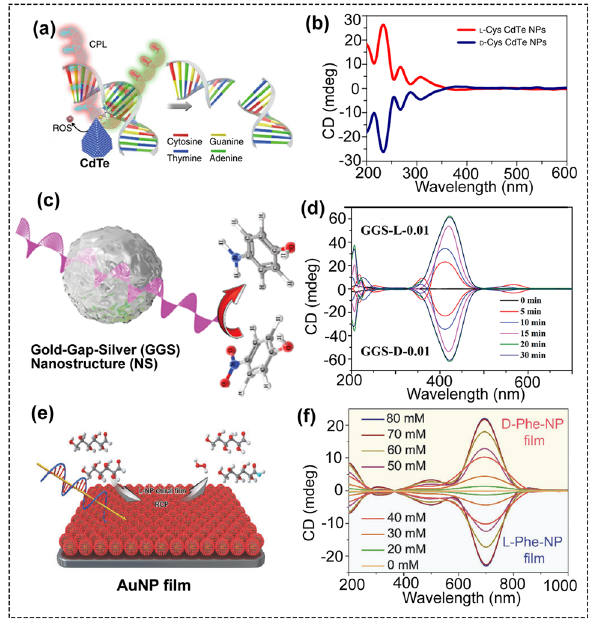
Fig. 7 a Schematic illustration of chiral CdTe-based specific DNA cleavage under CPL irradiation. b CD spectra of the chiral CdTe NPs (reproduced with permission from Ref. [88]. Copyright 2018 Nature publishing group). c Schematic illumination of the photocatalytic reduction of 4-nitrophenol by chiral Gold-Gap-Silver (GGS) nano- structures (NS). d CD spectra of GGS nanostructures prepared at different reaction times (reproduced with permission from Ref. [90]. Copyright 2015, WILEY–VCH GmbH). e Schematic illumination of photocatalytic oxidation of glucose enantiomers by chiral AuNP film. f CD spectra of the chiral AuNP films (reproduced with permission from Ref. [92]. Copyright 2018, WILEY–VCH